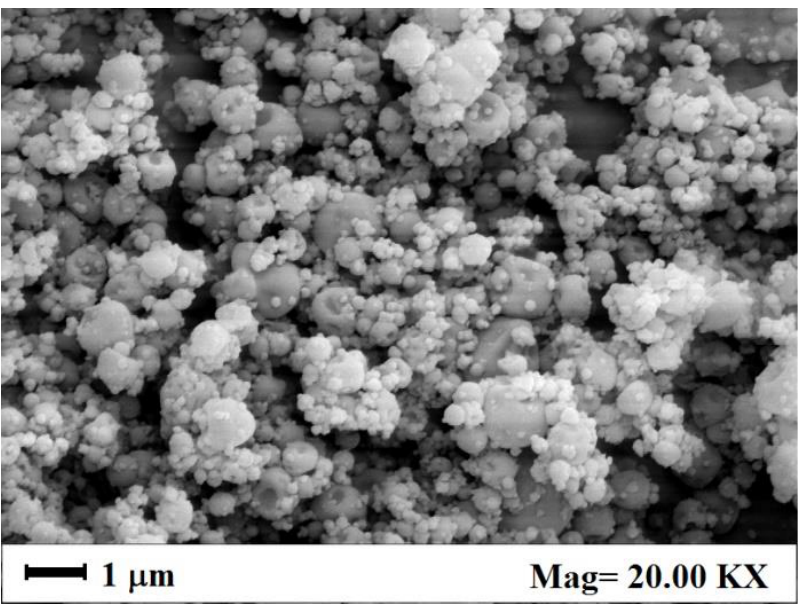
Figure 4. SEM image of Cur-PVP microparticles produced by SAA in this work, at a Cur-PVP weight ratio of 1/8.